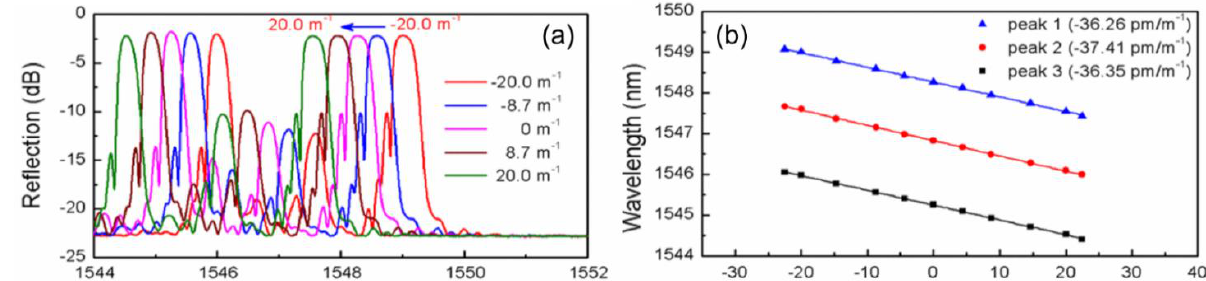
Figure 9. Bend response of the TC-FM FBG with different bend curvatures. ( a ) Reflection spectra evolution of the TC-FM FBG with different bend curvatures. ( b ) Wavelength shift of the three resonance peaks in the reflection spectra of the TC-FM FBG as a function of bend curvature. Adapted with permission from Ref. [41] © 2017 IEEE.